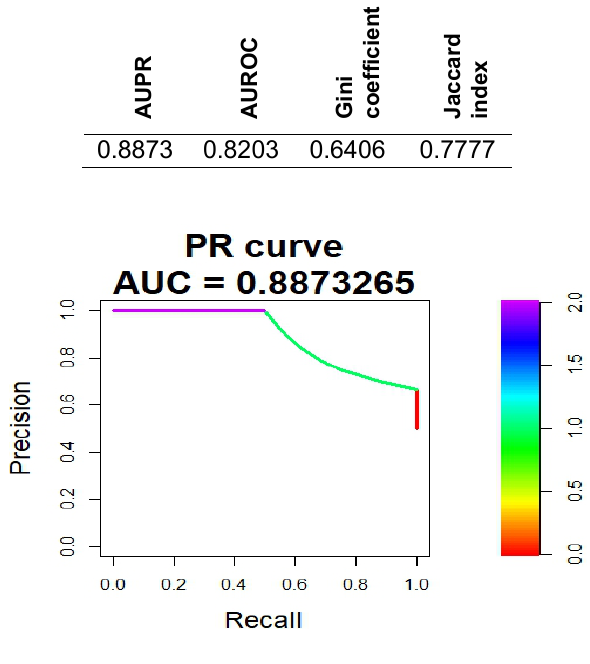
Figure 15. Area under PR curve for